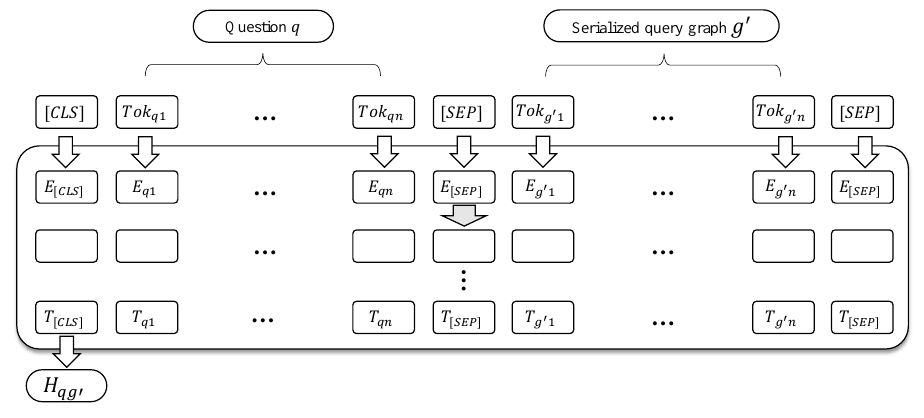
Figure 4. The input and output of RoBERTa for measuring the semantic